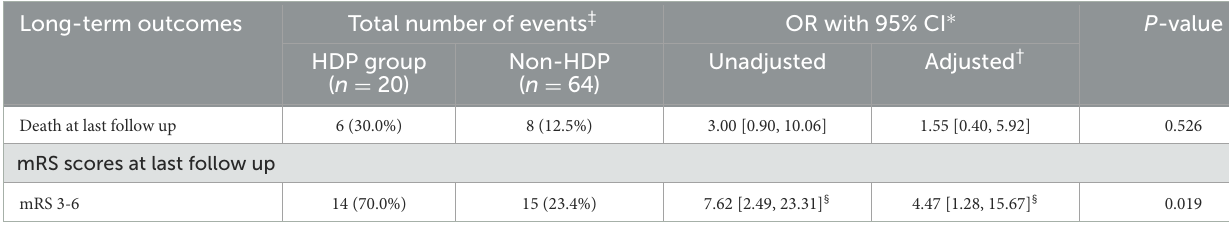
TABLE 5 Odds ratios (ORs) with confidence interval (CI) ∗ for long-term outcomes by hypertensive disorders of pregnancy (HDP) status among pregnancy-related hemorrhagic stroke. Long-term